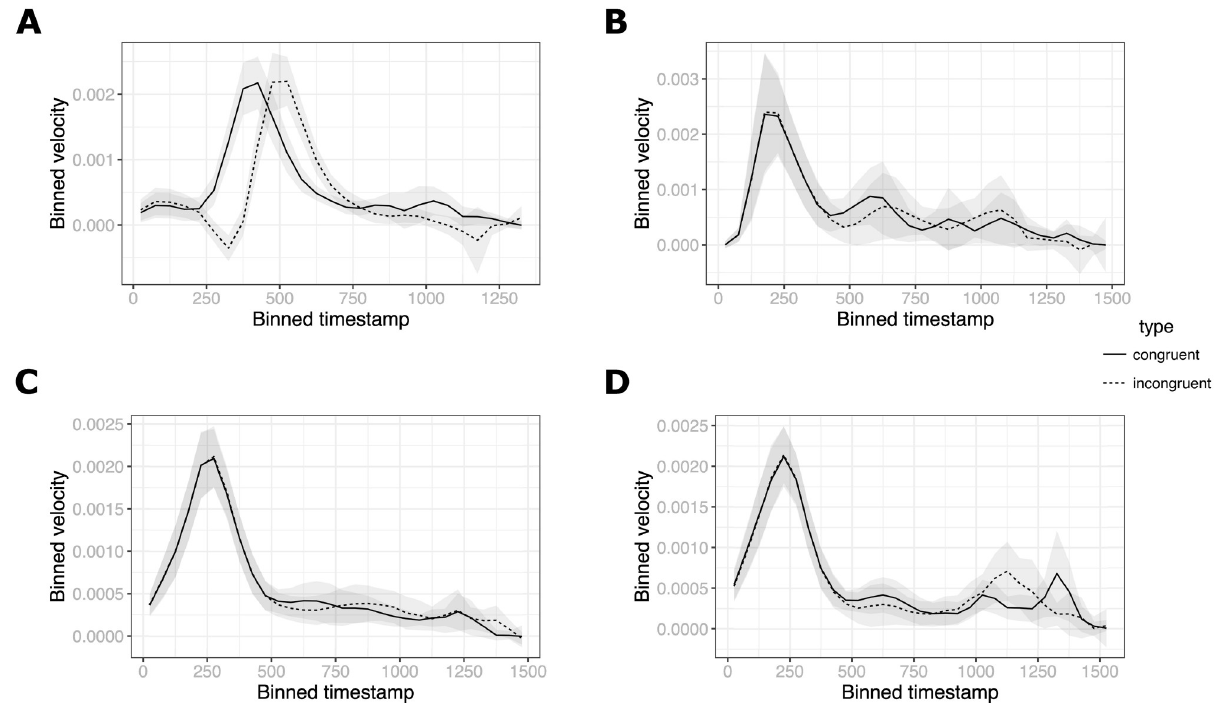
Fig 7. Binned velocity profiles in all experiments. Experiment 1 (A) shows a clear dissociation in time evolution of velocity between congruent and incongruent trials, especially in the beginning of the trial. Experiments 2 (B) and 3 (C: Online condition, D: Offline condition) show no difference.